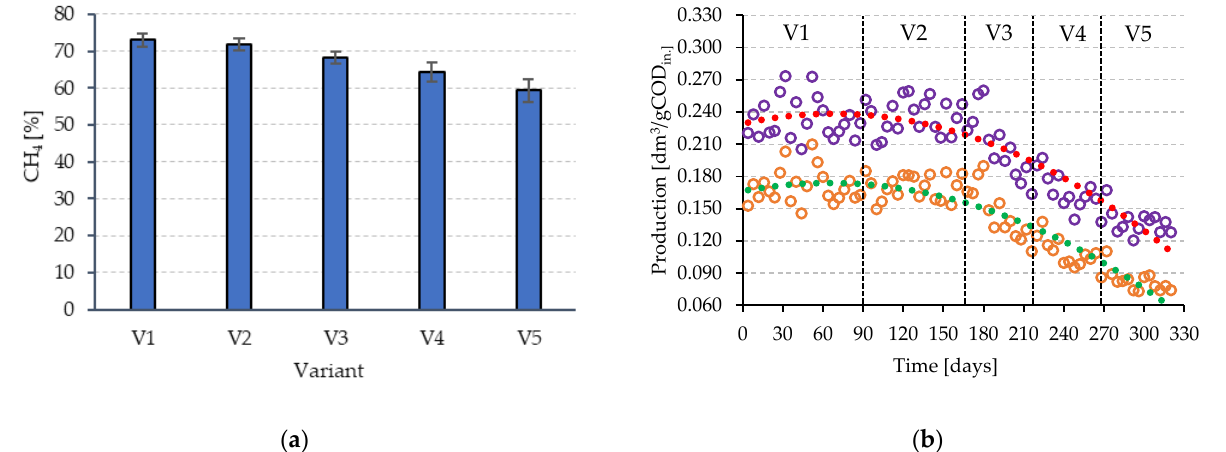
Figure 4. The efficiency of anaerobic dairy treatment in stage 1: ( a ) CH 4 concentration in biogas with a standard deviation in experimental variants V1–V5; ( b ) biogas and methane yield per gram of COD inlet during the experimental time (variants V1–V5).